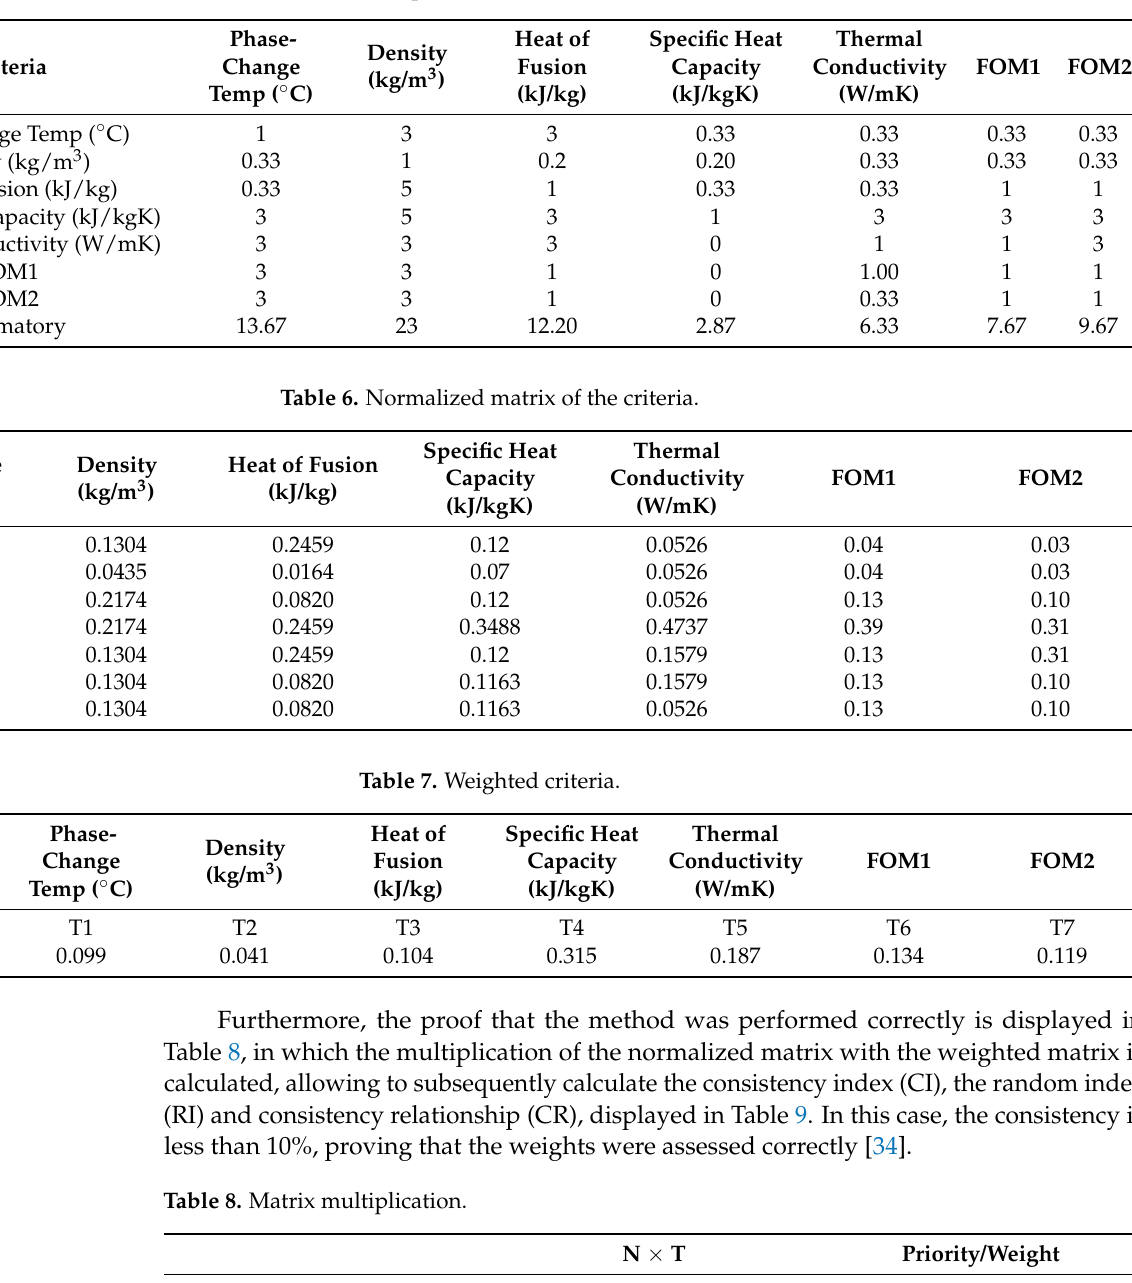
Table 5. Comparison matrix of the criteria.